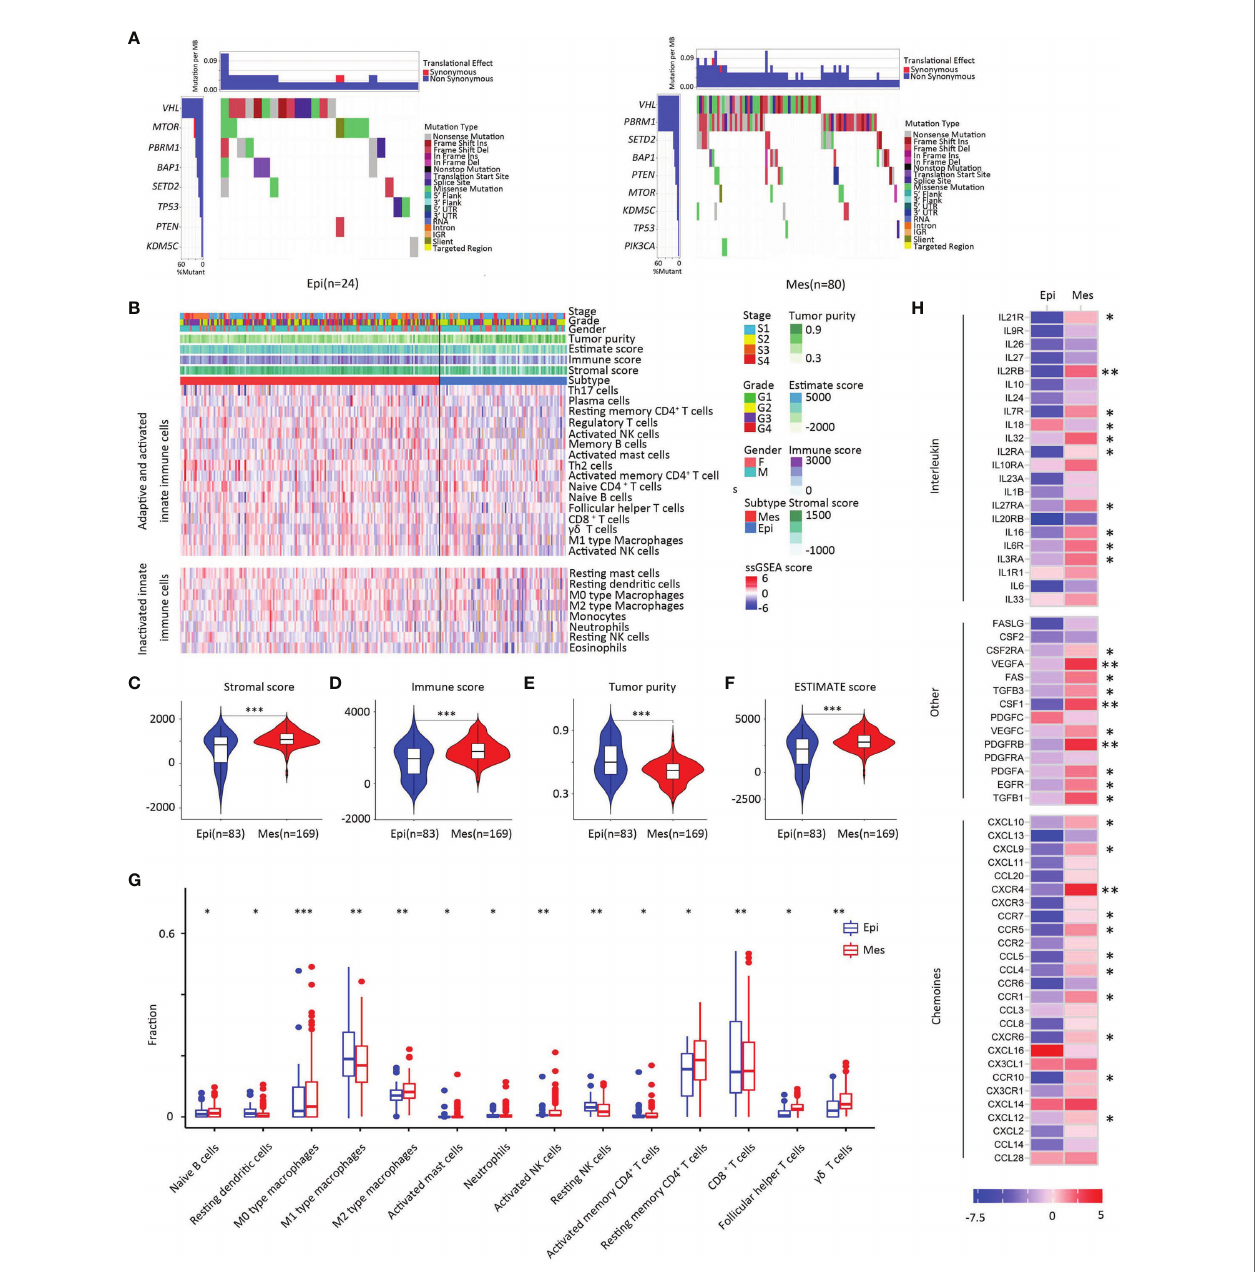
FIGURE 6 | Somatic alterations in EMT subtypes. (A) Upper heat map, mutation events per sample; lower heat map, mutation types, and events (left, Epi group; right, Mes group). (B) Landscape of the microenvironment phenotypes in EMT subtypes, K-means clustering of microenvironment phenotypes based on the estimated numbers of 24 microenvironment cell subsets calculated by ssGSEA (Epi type, blue; Mes type red). Tumor stage (stage I, light blue; stage II yellow; stage III, orange; stage IV, red), grade (grade 1, green; grade 2, yellow; grade 3, purple; grade 4, red), gender (male, blue; female, pink), and scores estimated by the ESTIMATE algorithm. (C – F) Scores of stromal, immune, tumor purity, and ESTIMATE between clusters. In the violin plots, the mean values are plotted as dots, and the boxplot is drawn inside of the violin plot. (G) Boxplot plot for comparison of the immune cell fraction difference between Epi and Mes tissues. Fractions of each immune cell type were compared by means of a two-sided Mann – Whitney U test. Blue color indicates Epi type and red indicates Mes type. (H) Log2-fold change in mRNA expression in the tumor tissues of chemokines, interleukins, interferons, and other important cytokines and their receptors for each cluster. Molecules with signi fi cantly differential expression between the tumor site and the paired normal site (P < 0.01) were illustrated. (***, P < 0.001; **, 0.001 < P < 0.01; *, 0.01 < P < 0.05; ns, P >